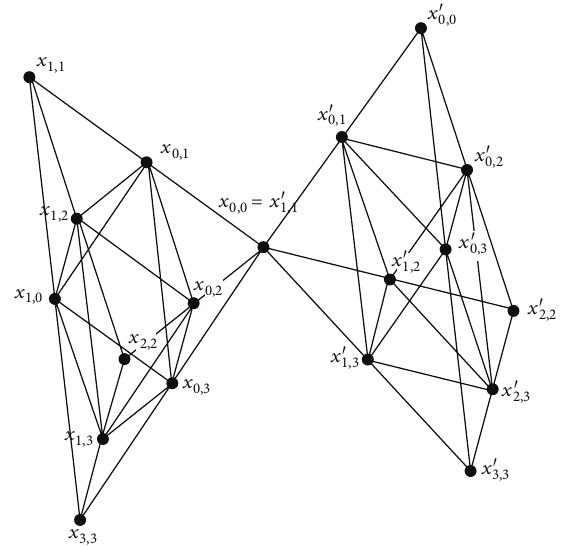
Figure 6: Two cells of level 𝑚 − 1 intersecting in a vertex of Γ 𝑚